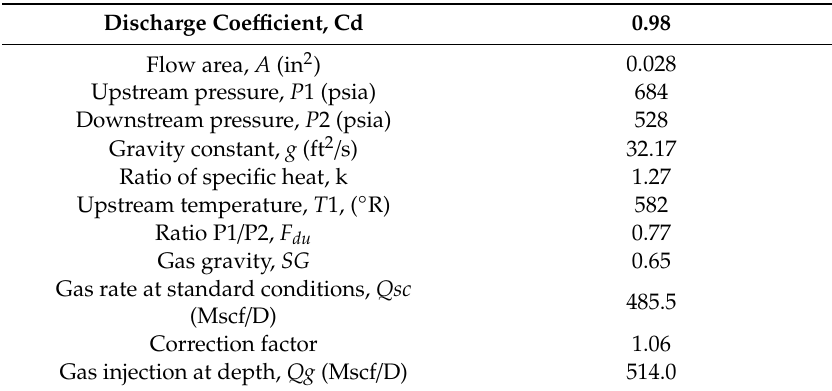
Table 2. Example of the gas lift rate calculation.